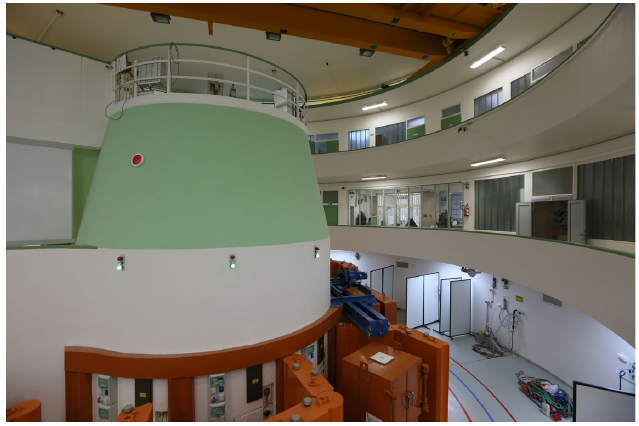
Fig. 5 . BME Training reactor, BME,